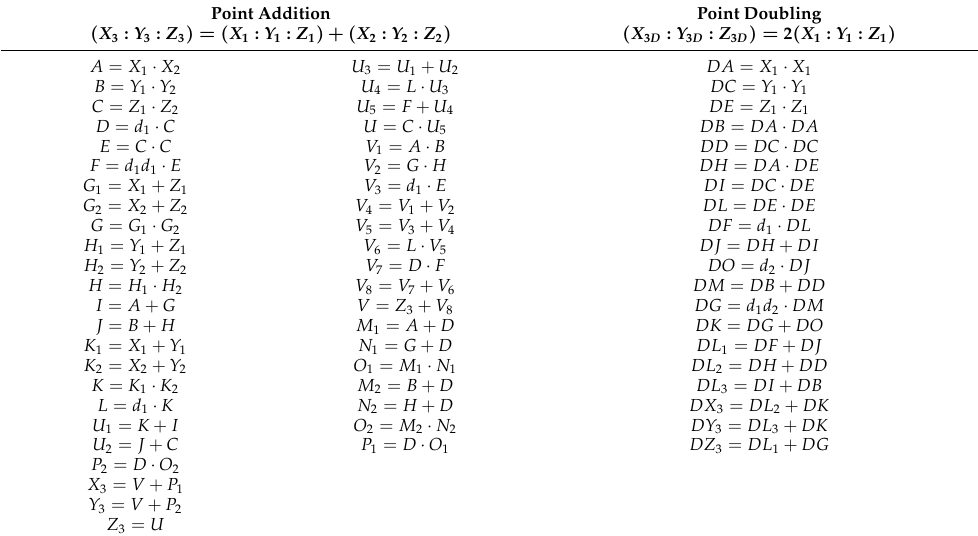
Table 1. Point Operations Partial Results